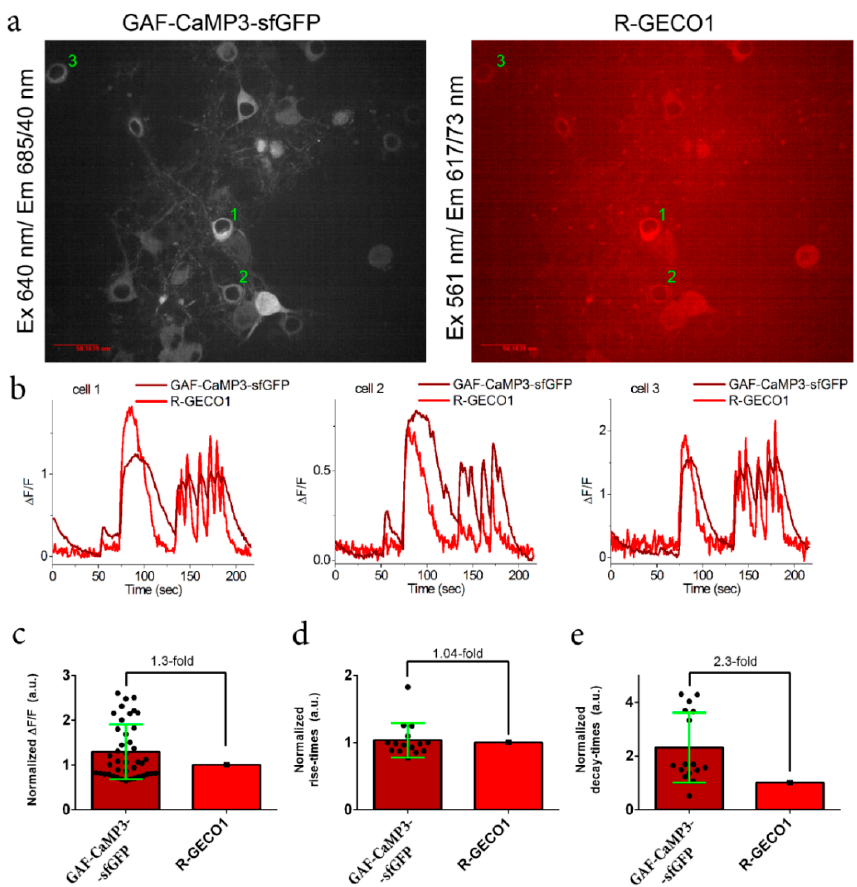
Figure 4. Two-color calcium imaging of the non-specific (spontaneous) activity of neuronal cultures co-expressing the near-infrared GAF-CaMP3–sfGFP and red R-GECO1 calcium indicators. ( a ) Confocal images of the neuronal cultures co-expressing the NES-GAF-CaMP3–sfGFP and NES-R-GECO1 indicators in the presence of 10 µ M of external BV. Scale bar, 50 µ m. BV (10 µ M) was added 5–24 h before imaging. The neuronal cultures co-expressing the NES-GAF-CaMP3–sfGFP and NES-R-GECO1 indicators were imaged on the 15th day in vitro (DIV). The neuronal cultures were transduced on the 4th DIV with the mixture of recombinant adeno-associated viruses (rAAVs) carrying NES-GAF-CaMP3–sfGFP and NES-R-GECO1. ( b ) Examples of ∆ F / F traces for the three cells marked on panel ( a ) as 1, 2, and 3 (see Figure S3 for more traces). ( c ) ∆ F / F responses of the GAF-CaMP3–sfGFP indicator normalized to the ∆ F / F response of R-GECO1 in the same cell. The rise ( d ) and decay ( e ) times for GAF-CaMP3–sfGFP normalized to the respective times for R-GECO1 in the same cell. ( c–e ) Error bars are standard deviations across 5–8 cells and 15–42 spikes.